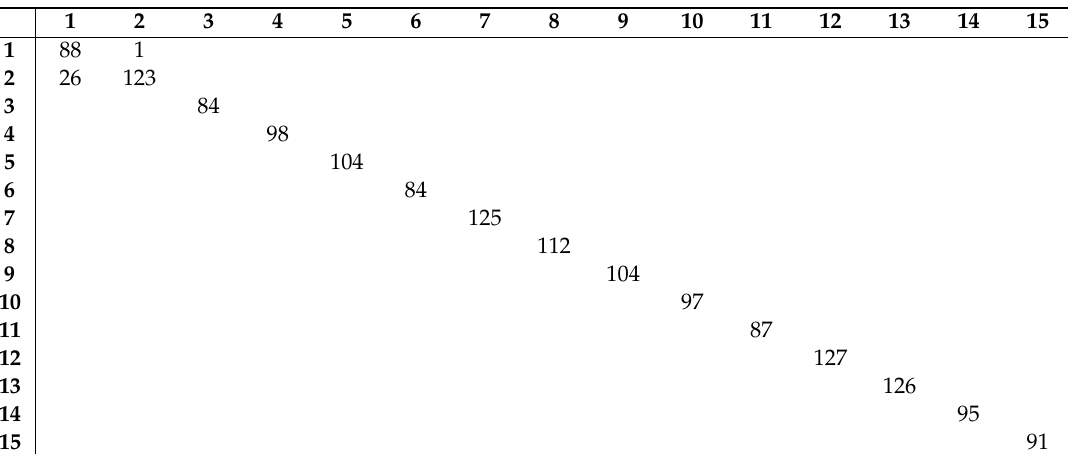
Table 5. Static neural network confusion